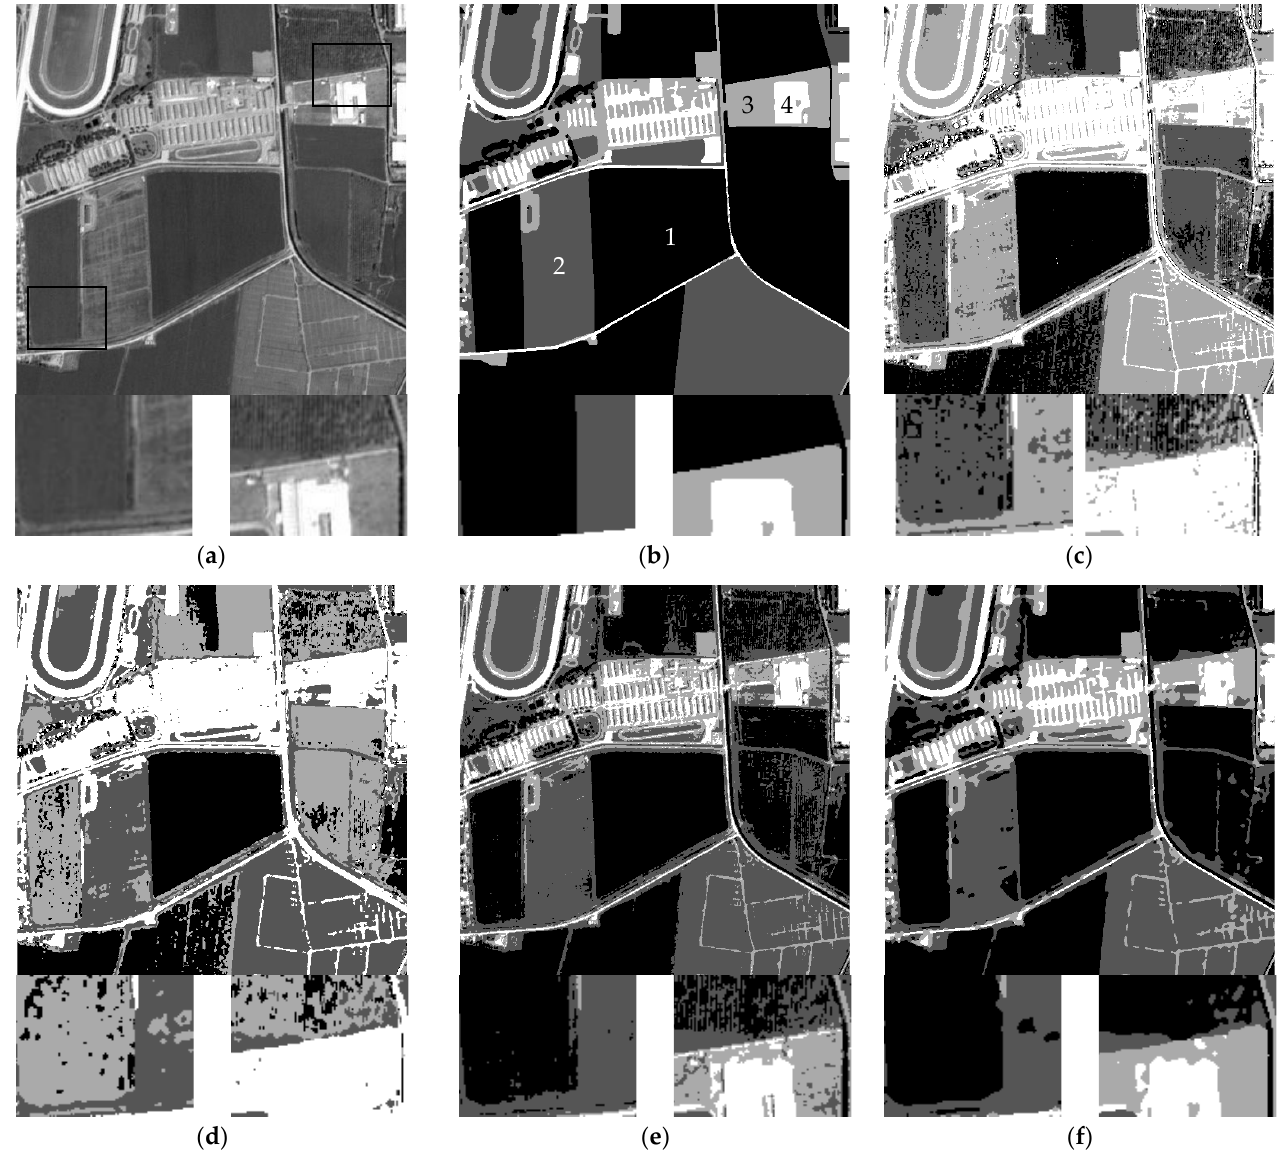
Figure 9. Large scale panchromatic image with high-resolution and its segmentation results. ( a ) high-resolution panchromatic images, and the region in the black square is highlighted, ( b ) standard segmentation images, and 1 – 4 are the labels of regions, ( c ) FCM algorithm, ( d ) GMM algorithm, ( e ) SMM algorithm, ( f ) HSMM algorithm.